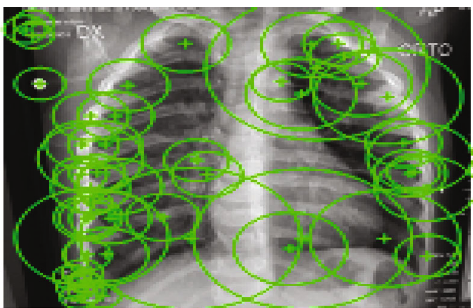
Figure 4: The discriminative SURF features extracted from the X-ray